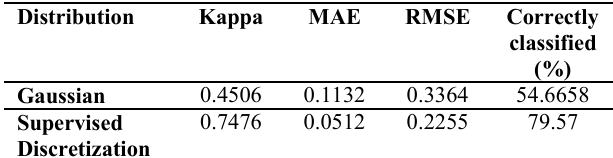
Table 5. Comparison of Gaussian and Supervised